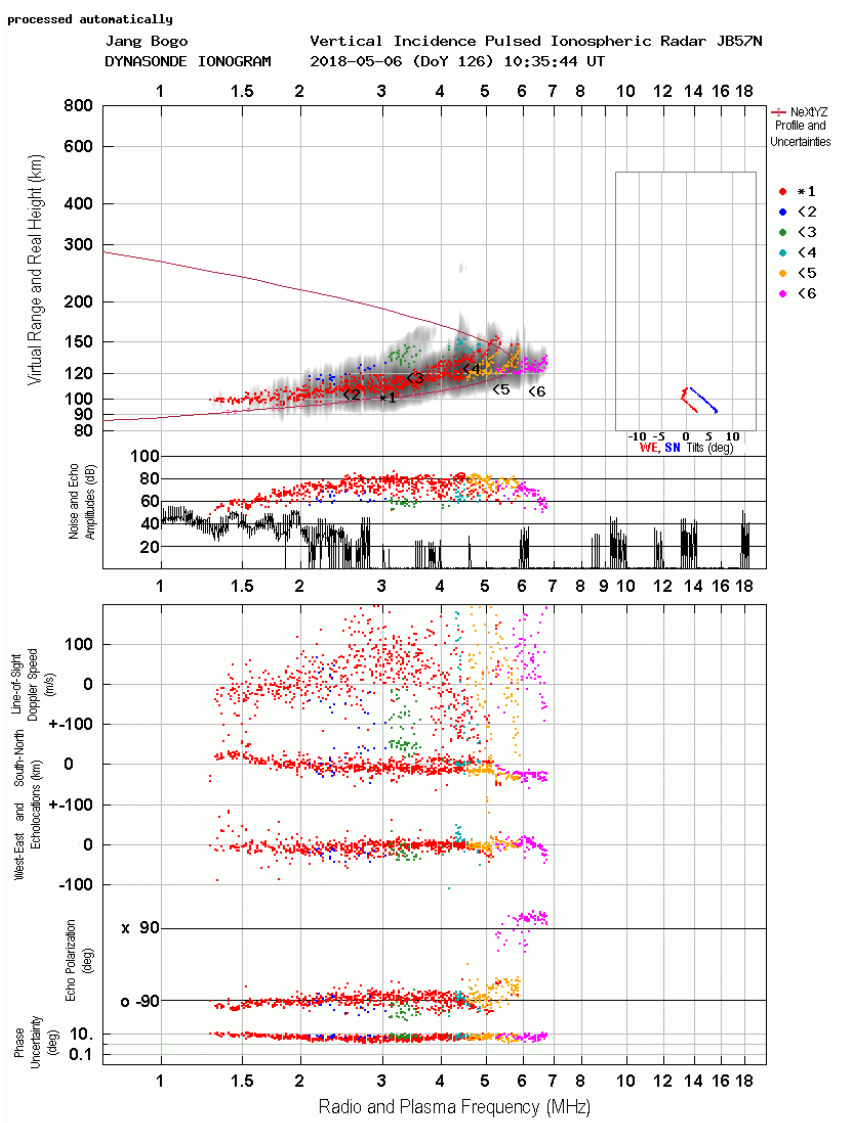
Figure 6. An example of the ionogram and resulting density profile obtained by JVD in winter at night on 6 May 2018 when the F10.7 was 68.4 sfu and the Kp index was 3.